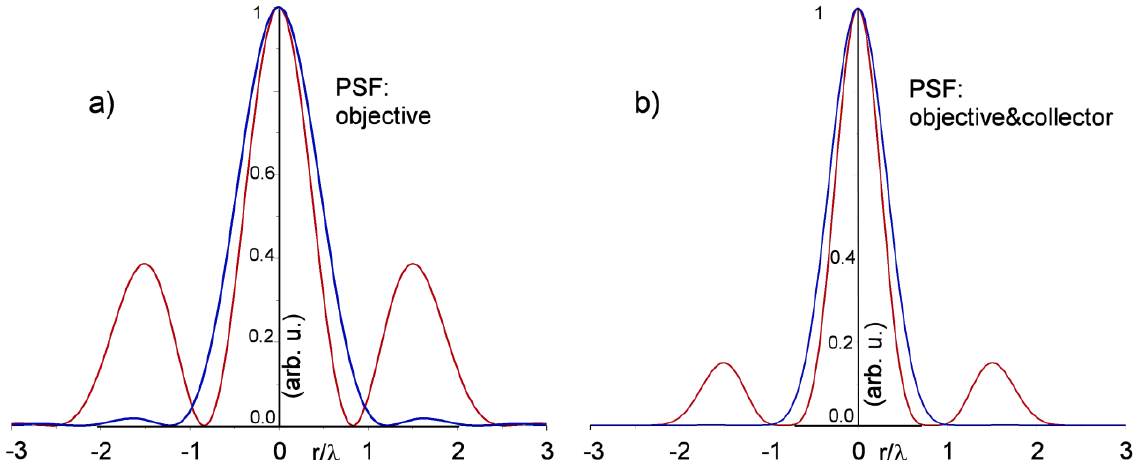
Figure 3. ( a ) Calculated PSF profile of a 0.52 NA objective (blue line) and a 0.52 NA annular aperture objective with 17% central obscuration; ( b ) Calculated PSF profile of the same objective as in (a) followed by the collecting lens (coinciding with the same objective). Normalized radial units are